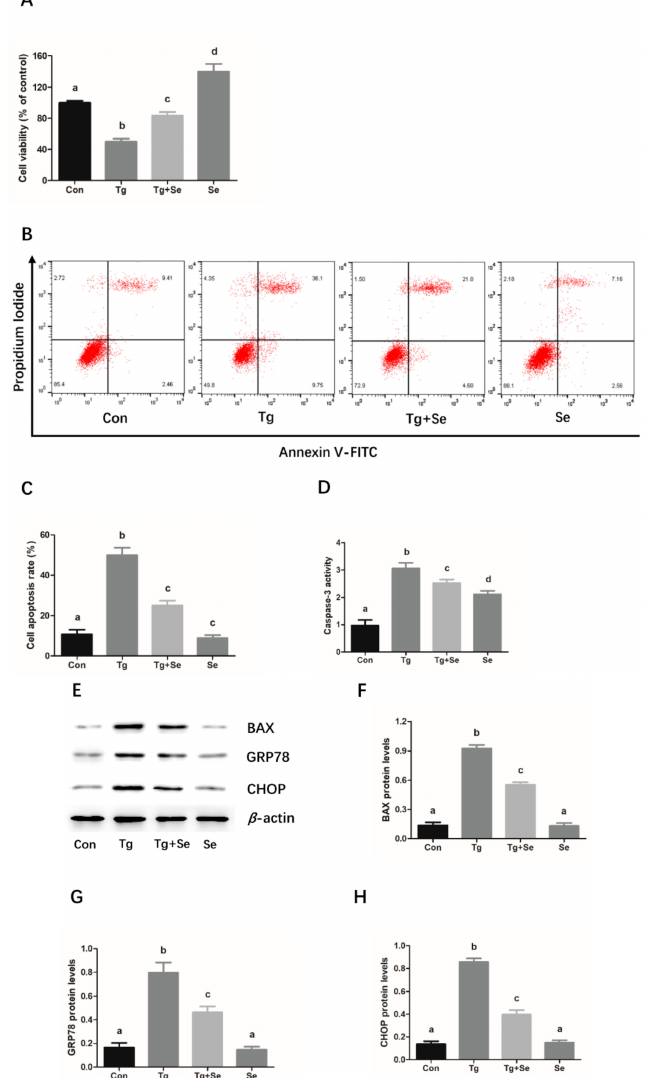
Figure 4. Sodium selenite attenuates Tg-induced apoptosis and ER stress in mouse granulosa cells. Cells were treated with Tg (500 nM) in the absence or presence of sodium selenite (5 ng / mL) at 37 ◦ C for 24 h, and then processed for cell viability and apoptosis analysis by CCK-8 kit ( A ) and flow cytometry ( B , C ), respectively. Caspase 3 Activity of the MGCs is measured by a colorimetric assay kit ( D ). Western blotting ( E ) was used to analyze the protein expression of BAX ( F ), GRP78 ( G ), and CHOP ( H ). β -actin was used to normalize the protein expression levels. The statistical analysis results are shown as bar graphs. The data are represented as the mean ± SEM of three independent experiments, and each independent experiment includes three technical replicates. Bars with di ff erent lowercase letters are significantly di ff erent ( p <